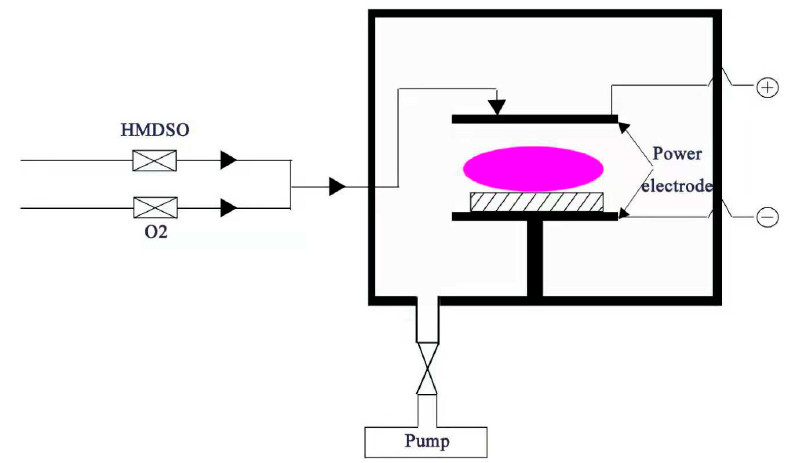
Figure 7. The schematic of the PECVD equipment.